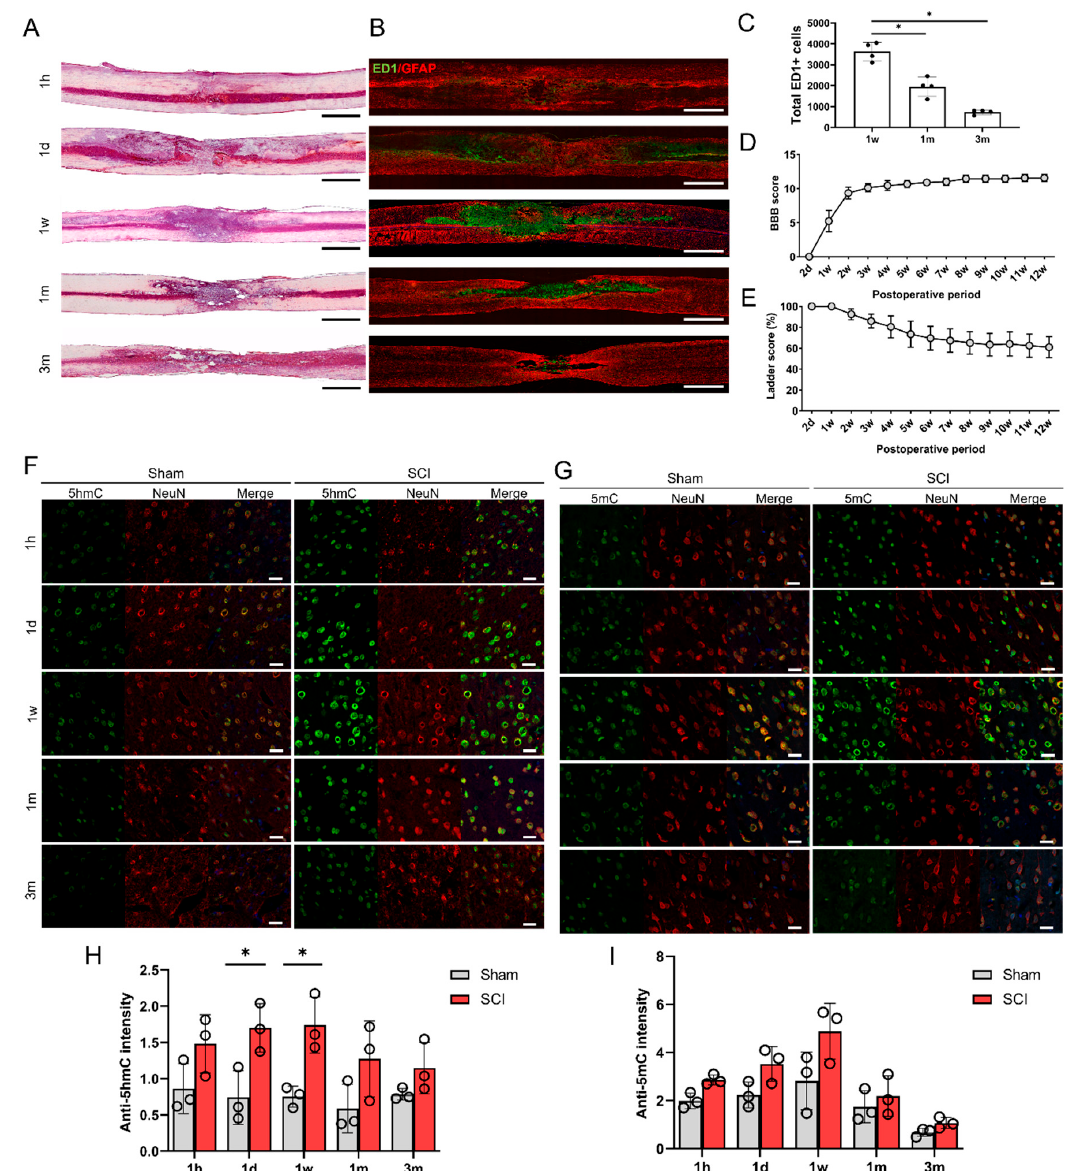
Figure 1. Histological and functional changes following spinal cord contusion injury in rats. ( A ) Representative images of hematoxylin and eosin staining of contused spinal cords at 5 time points (1 h (1 h), 1 day (1 d), 1 week (1 w), 1 month (1 m), and 3 months (3 m)). Black and white scale bars = 1000 µ m. ( B ) Representative immunohistochemical images of ED1 (green) and GFAP (red) in contused spinal cords at 5 time points. ( C ) The total numbers of ED1-positive cells within sagittal sections from immunohistochemical images of contused spinal cords at 1 week (1 w), 1 month (1 m), and 3 months (3 m) ( n = 4 at each time point); * p < 0.05 between groups by one-way analysis of variance (ANOVA) and Games–Howell post hoc tests. ( D , E ) Basso-Beattie-Bresnahan (BBB) scores ( D ) and ladder scores ( E ) of spinal cord injury (SCI) models from 2 days (2 d) to 12 weeks (12 w) after injury ( n = 7). ( F , G ) Representative immunohistochemical images of double staining of 5hmC (green) and NeuN (red) ( F ), and of 5mC (green) and NeuN (red) ( G ) in the primary motor cortexes of sham control rats and SCI model rats at 5 time points ( G ). Staining of 5mC ( H ) within the primary motor cortexes of sham and SCI rats at 5 time points ( n = 3 at each time point). White scale bars = 20 µ m. ( H , I ) The 5hmC ( H ) and 5mC ( I ) intensity in neurons in the primary motor cortexes of sham control ( n = 3) and SCI model rats ( n = 3) at 5 time points; * p < 0.05 between the sham control and SCI group by the Mann-Whitney U test.